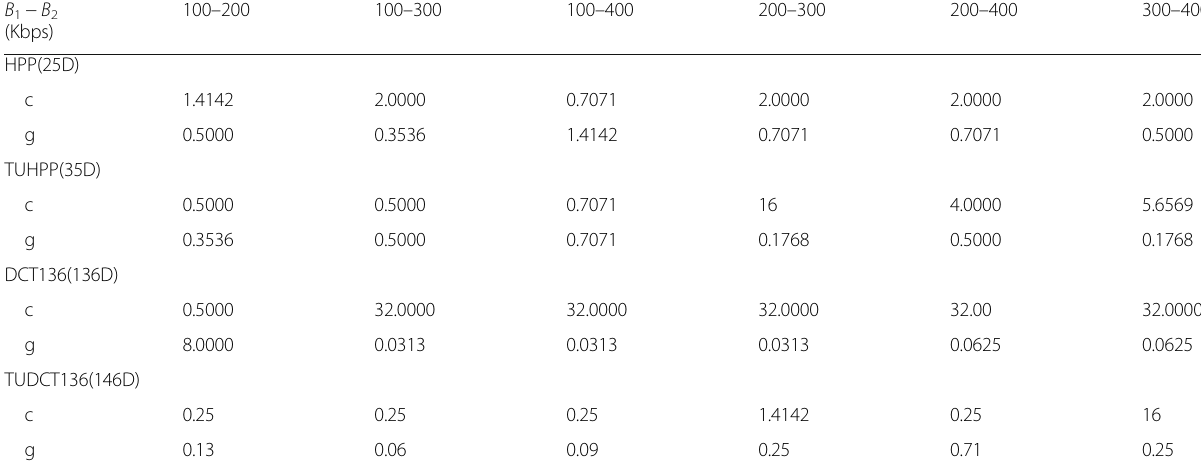
Table 7 The parameters used for training libSVM for feature set HPP [15], TUHPP, DCT136 [11], and TUDCT136 on QCIF video dataset